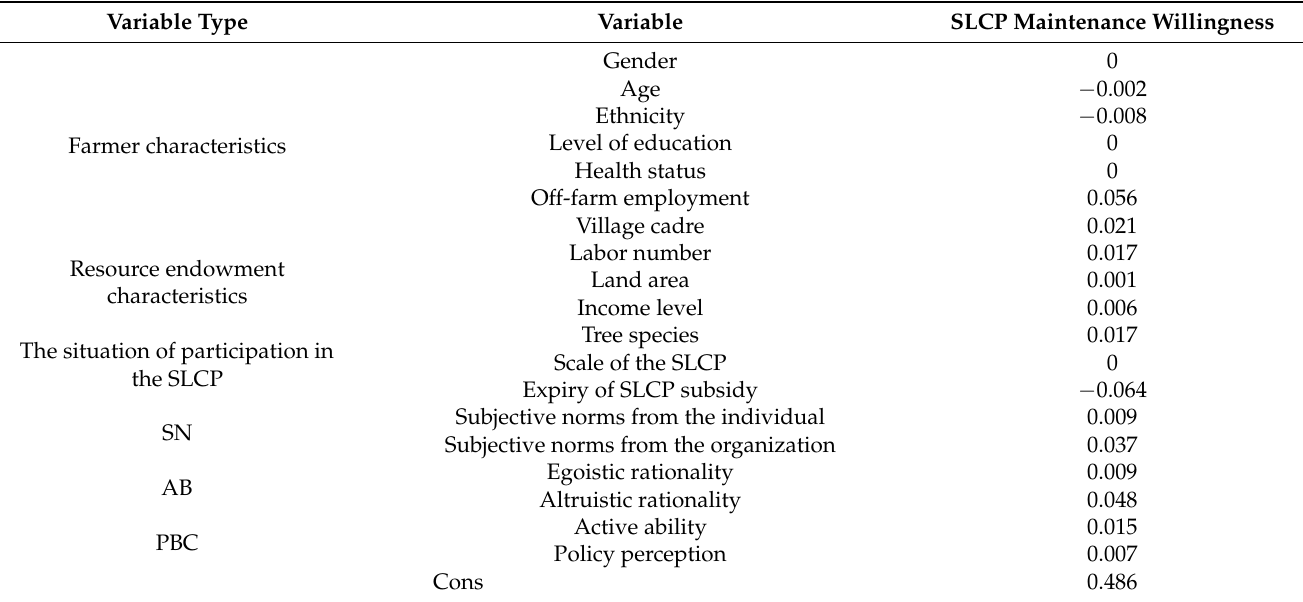
Table 3. Selection results of the elastic net model.